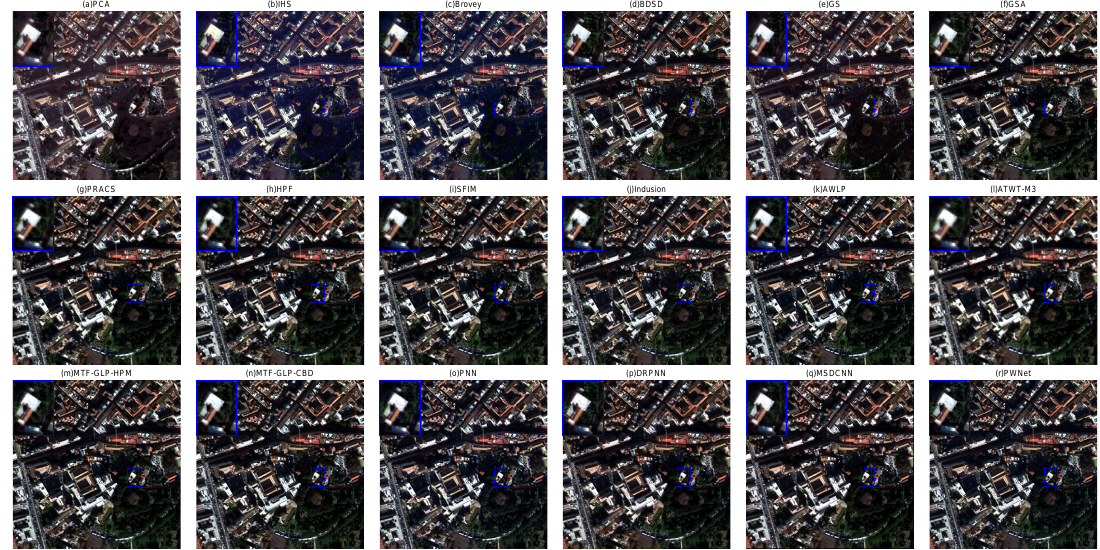
Figure 14. Visual comparison of different methods on the WorldVie-2 data set at full resolution, ( a ) PCA; ( b ) GIHS; ( c ) Brovey; ( d ) BDSD; ( e ) GS; ( f ) GSA; ( g ) PRACS; ( h ) HPF; ( i ) SFIM; ( j ) Indusion; ( k ) AWLP; ( l ) ATWT-M3; ( m ) MTF-GLP-HPM; ( n ) MTF-GLP-CBD; ( o ) PNN; ( p ) DRPNN; ( q ) MSDCNN; ( r ) PWNet (ours).